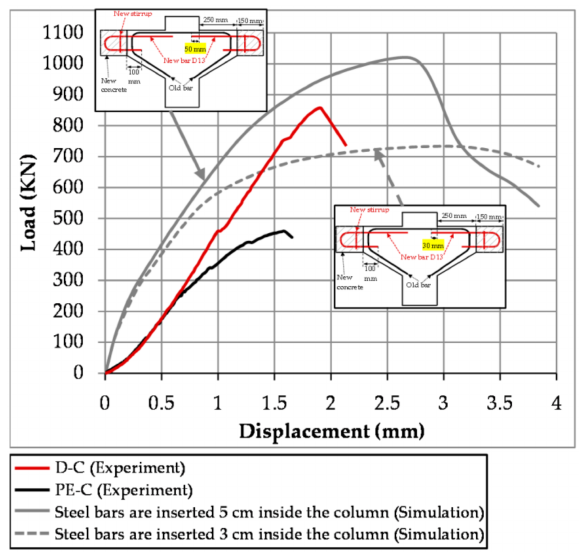
Figure 14. Load-displacement relationships for parametric study of the effect of the rebar anchorage length inside the